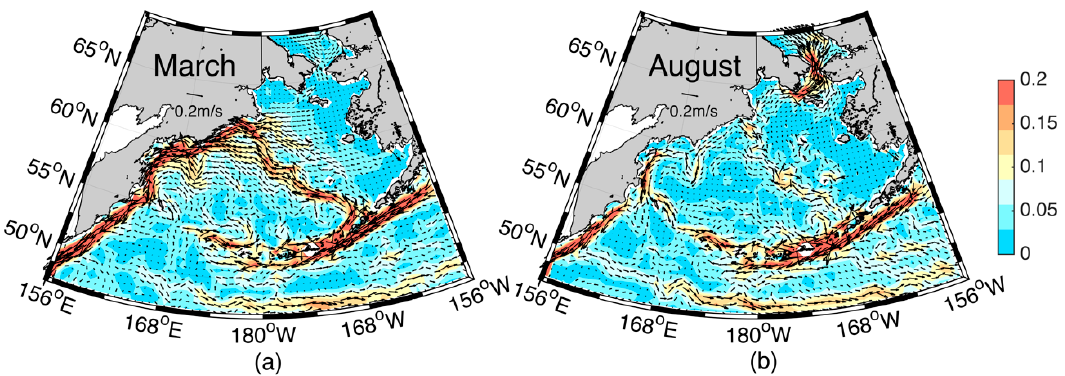
Figure 5. Seasonal variation in the surface mean circulations in the Bering Sea: ( a ) March and ( b ) August, which are from the ROMS solution averaged over 15 years from 1990–2004. The vector and shading represent the direction and the speed of the current, respectively (Unit: m / s ). Vectors are plotted every 8 grid points.